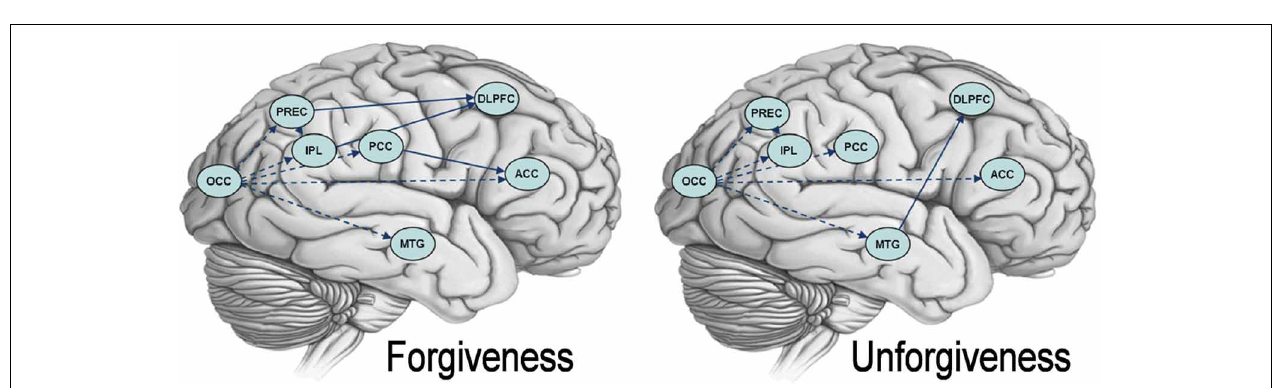
FIGURE 2 | Activation patterns elicited during forgiveness as compared to unforgiveness. The figure shows brain areas active while subjects granted forgiveness to imagined offenders. Statistical parametric maps ( p < 0 . 01, corrected) of activation elicited by